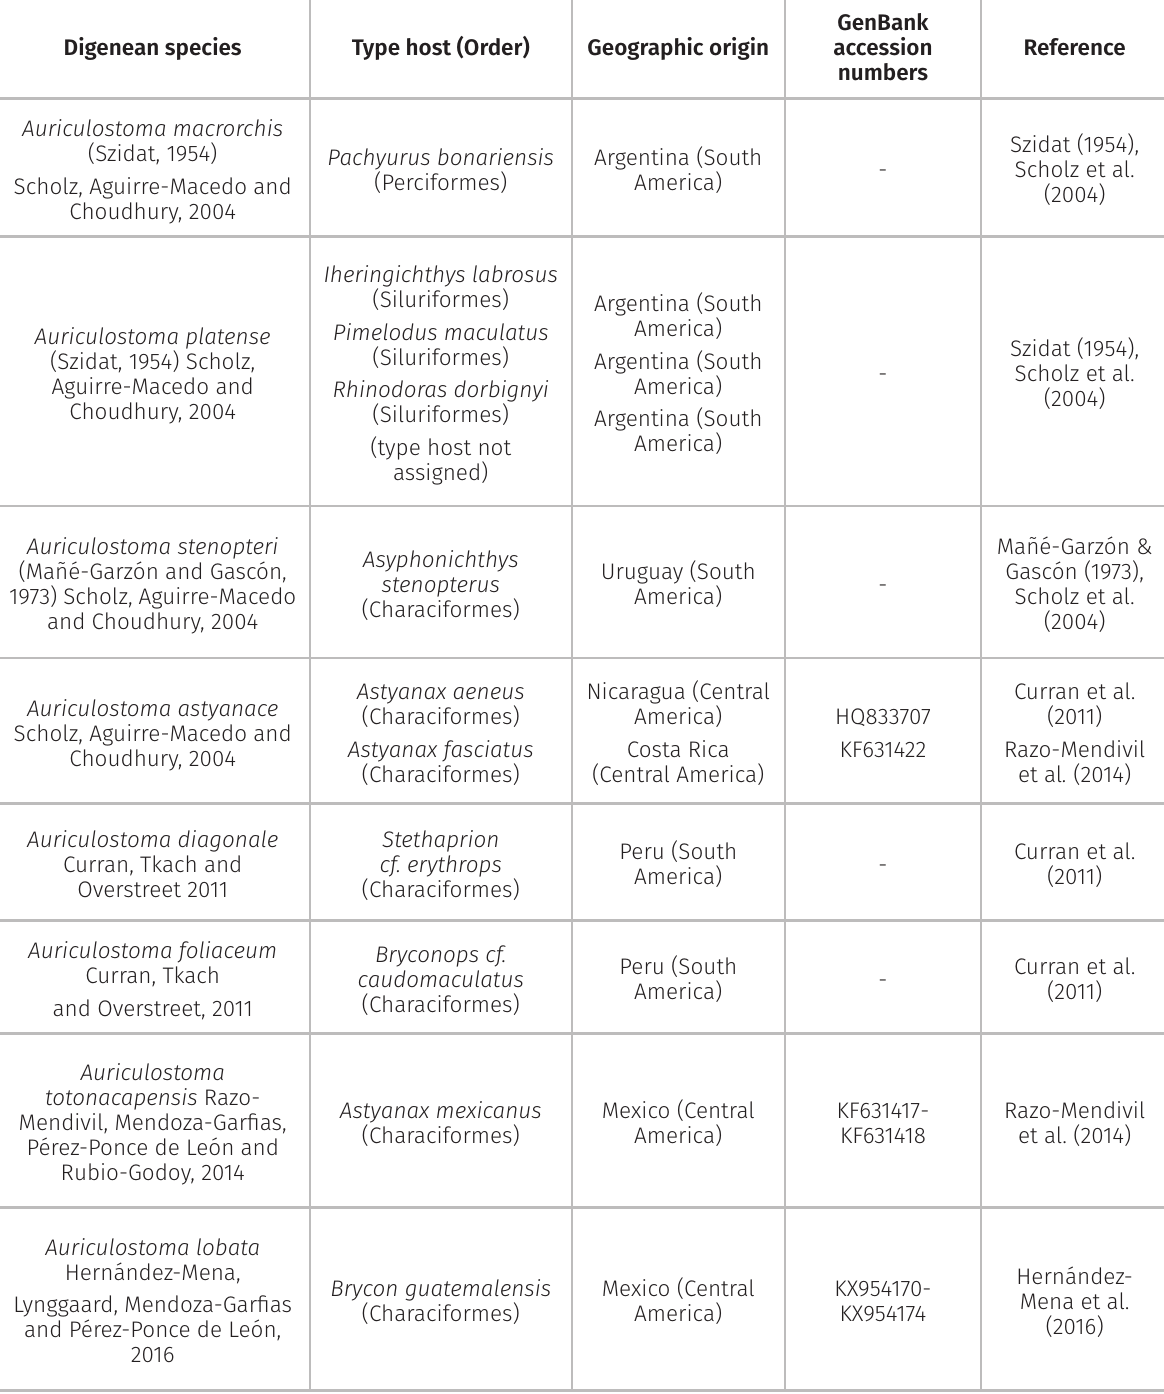
Table I. Species of Auriculostoma associated with their hosts and geographic origin (new species is in bold); 28S and ITS2 sequences are recorded for Auriculostoma ocloya n.